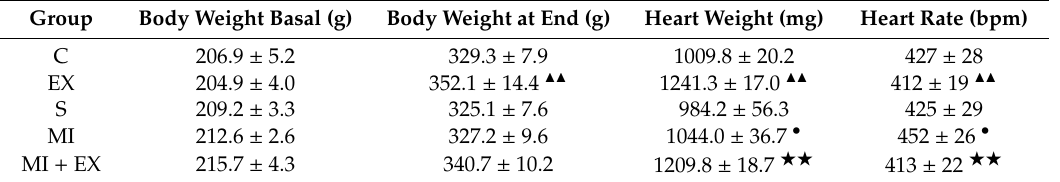
C, Control group; EX, Exercise alone group; S, Sham-operated group; MI, Myocardial infarction group; MI + EX, MI with post-MI interval exercise training group. The values are Mean ± Standard Deviation (SD), n = 10 / group. Symbols : (cid:78)(cid:78) p < 0.01 versus Group C; • p < 0.05 versus Group S; (cid:70)(cid:70) p < 0.01 versus Group